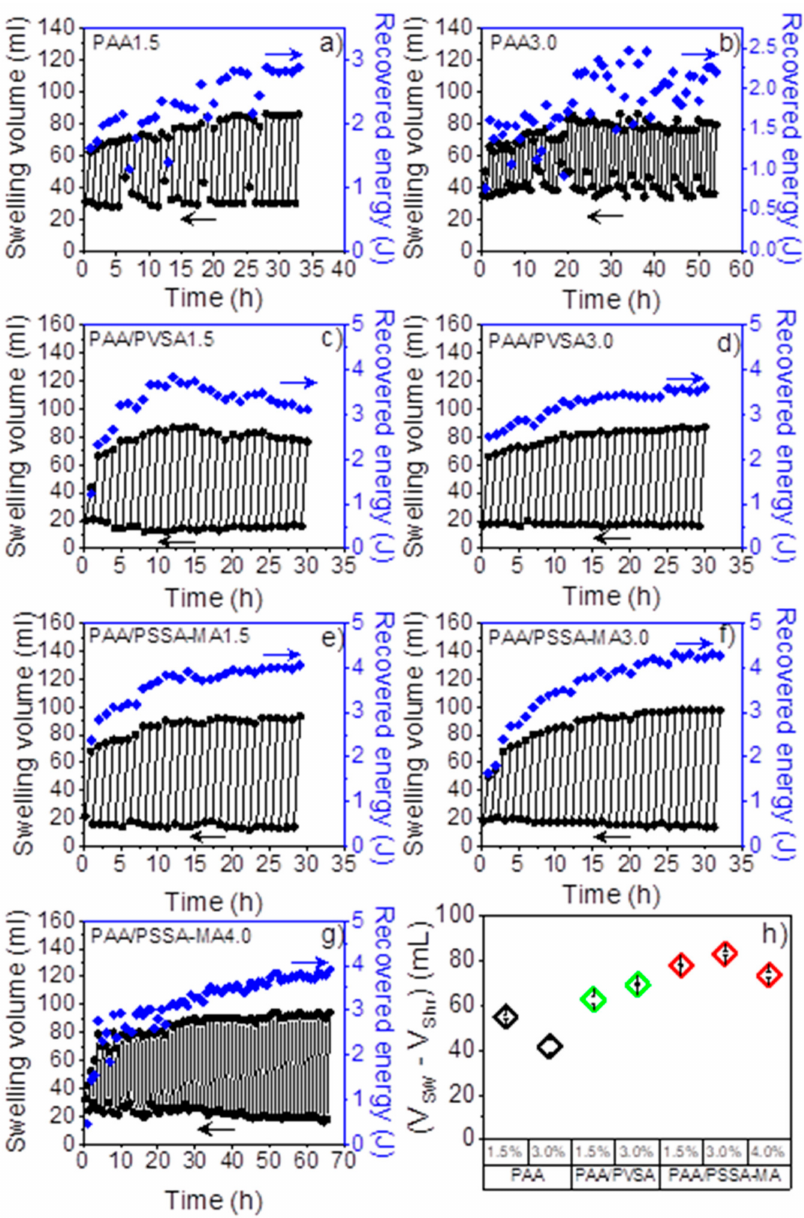
Figure 6. Repeated swelling cycles as a function of time: ( a ) PAA1.5; ( b ) PAA3.0; ( c ) PAA/PVSA1.5; ( d ) PAA/PVSA3.0; ( e ) PAA/PSSA-MA1.5; ( f ) PAA/PSSA-MA3.0; ( g ) PAA/PSSA-MA4.0; and ( h ) Av- erage volume difference between swollen and shrunken volume of the 6 last